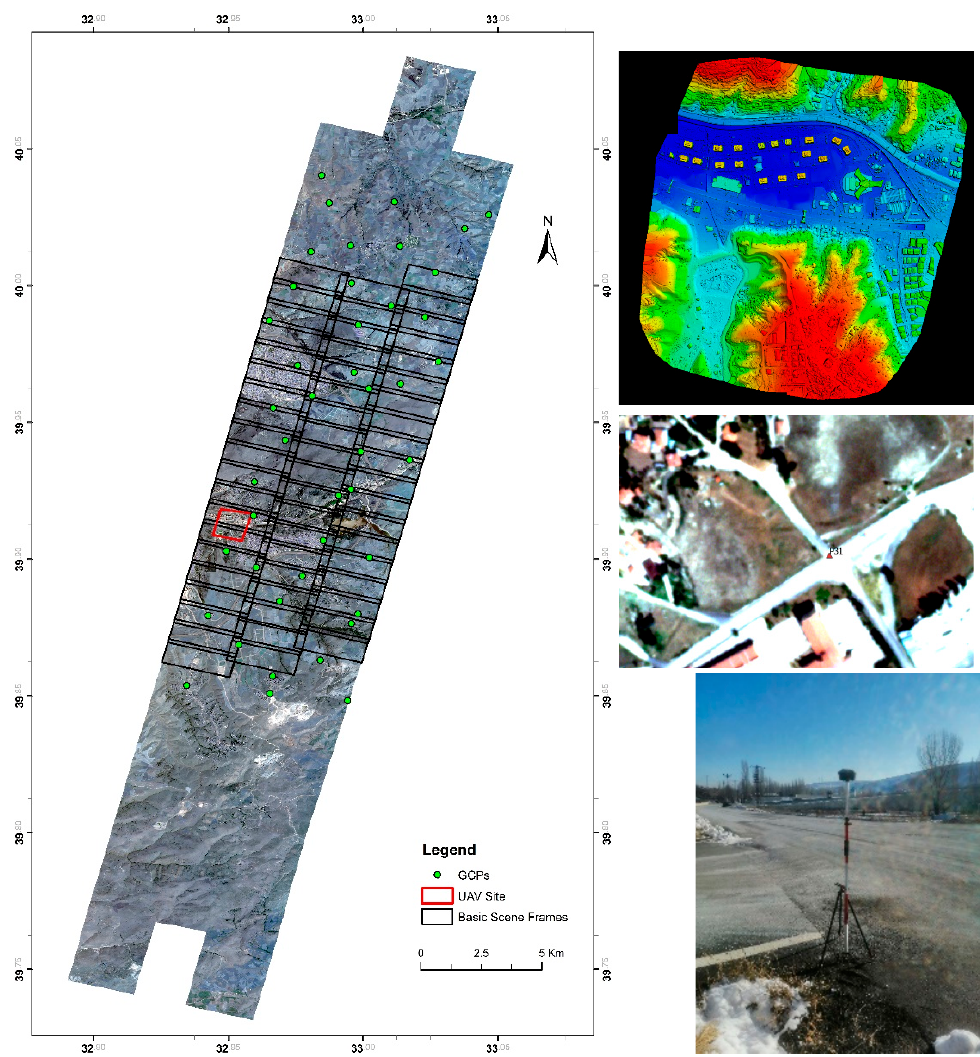
Figure 2. An overview of the SkySat Collect data acquired over the Ankara test site on 18 July 2020 with the GCP distribution ( left ); and the reference UAV DSM and a GCP located on the SkySat Collect image and on the ground ( right ).